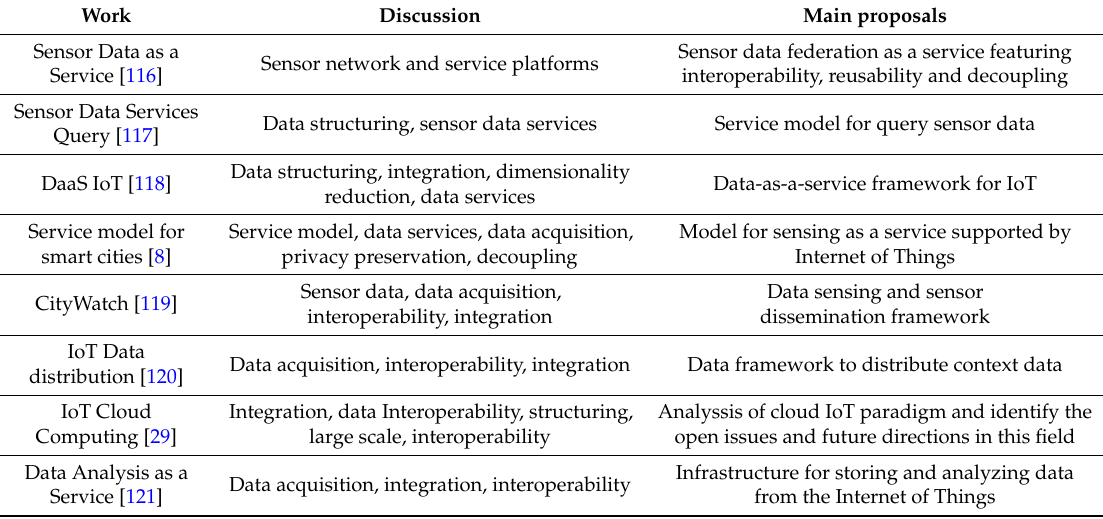
Table 5. Recent work on sensing and IoT data acquisition